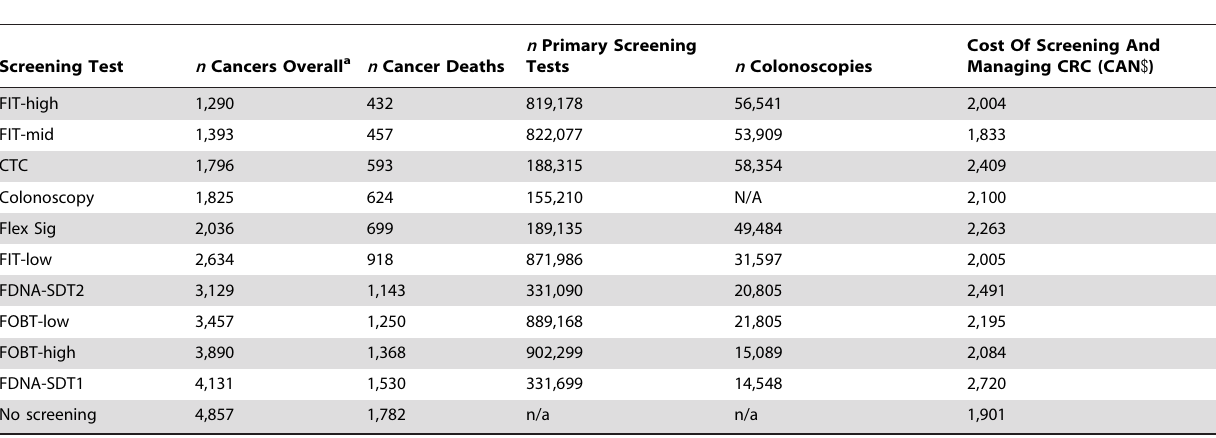
Table 5. Cancer outcomes and number of screening tests required during the lifetimes for a hypothetical 100,000 average risk patient cohort.